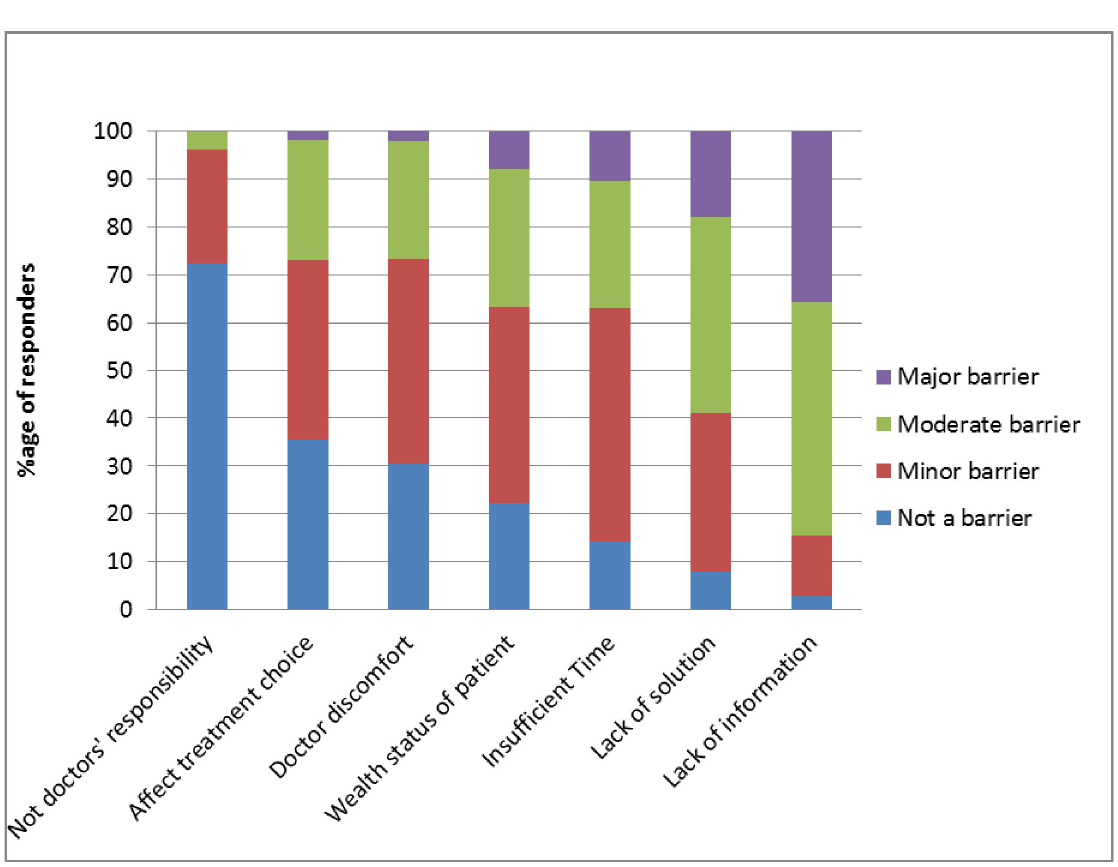
Fig 5. Current and potential barriers to discussion of costs in clinics by